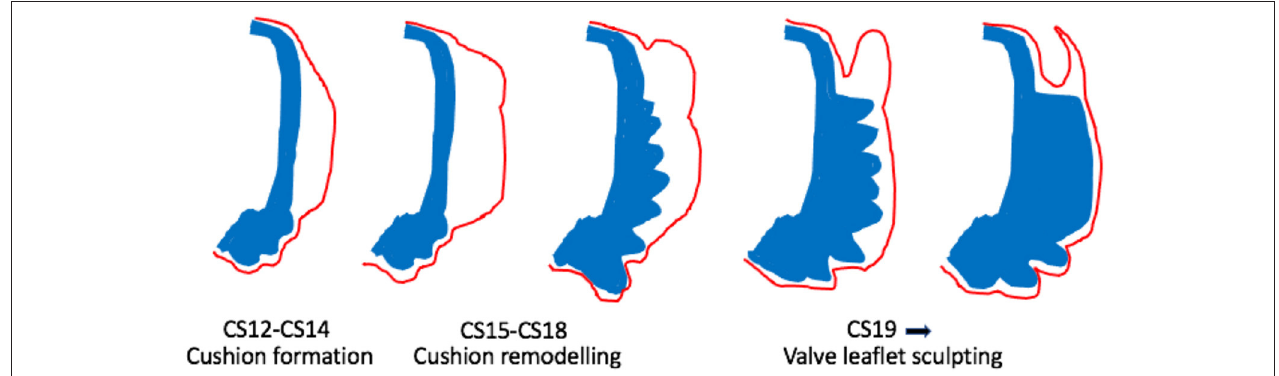
FIGURE 3 | Cartoon illustrating morphological changes in outflow cushion/valve formation. The outflow cushions first appear at CS12-14 (equivalent to mouse E10-E11). Between CS15-18, the distal parts of the cushions remodel to form the valve precursors. From CS19 onwards, these valve precursors are sculpted to produce the thin valve leaflets with the sinus behind. Blue denotes the outflow wall. Red denotes the